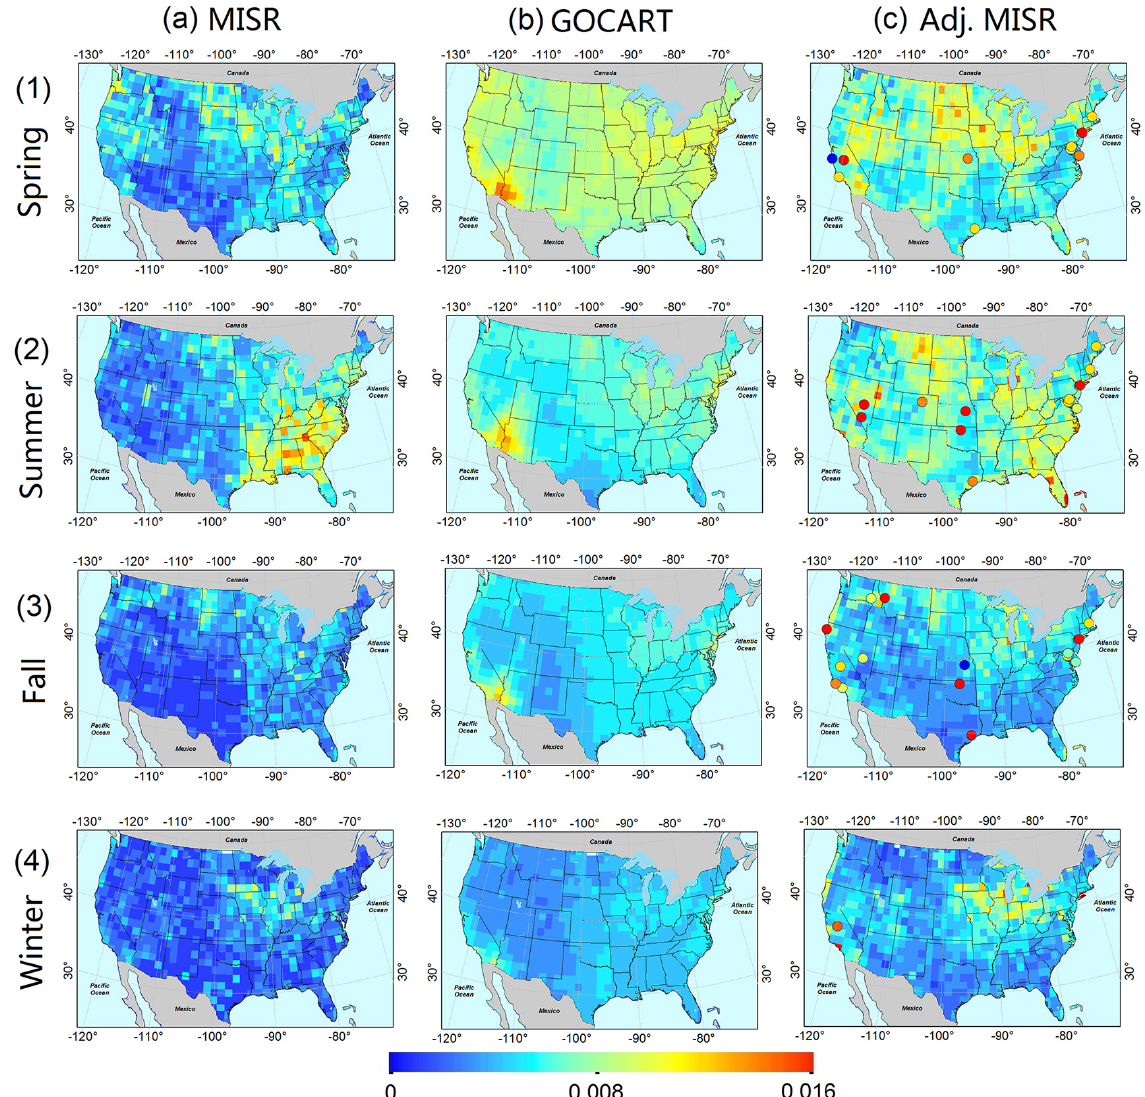
Figure 6. Same as Fig. 5, but for AAOD distributions. Note the color bar is from 0 to 0.016.